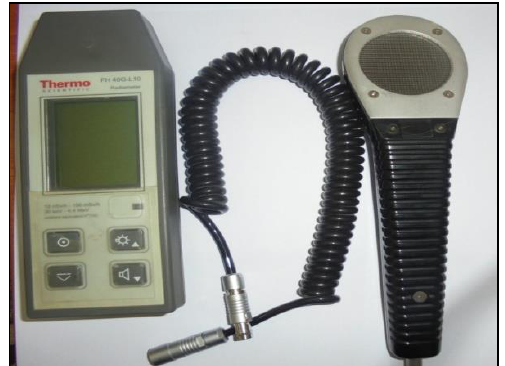
Fig. 3: Photo of FH-40